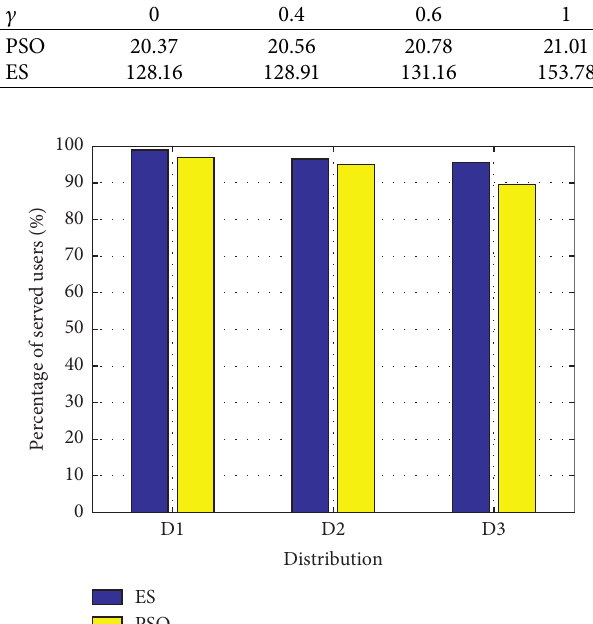
Figure 5: Deployment of the CoW and UAV using ES algorithm when the priority is given to the UAV at the beginning.